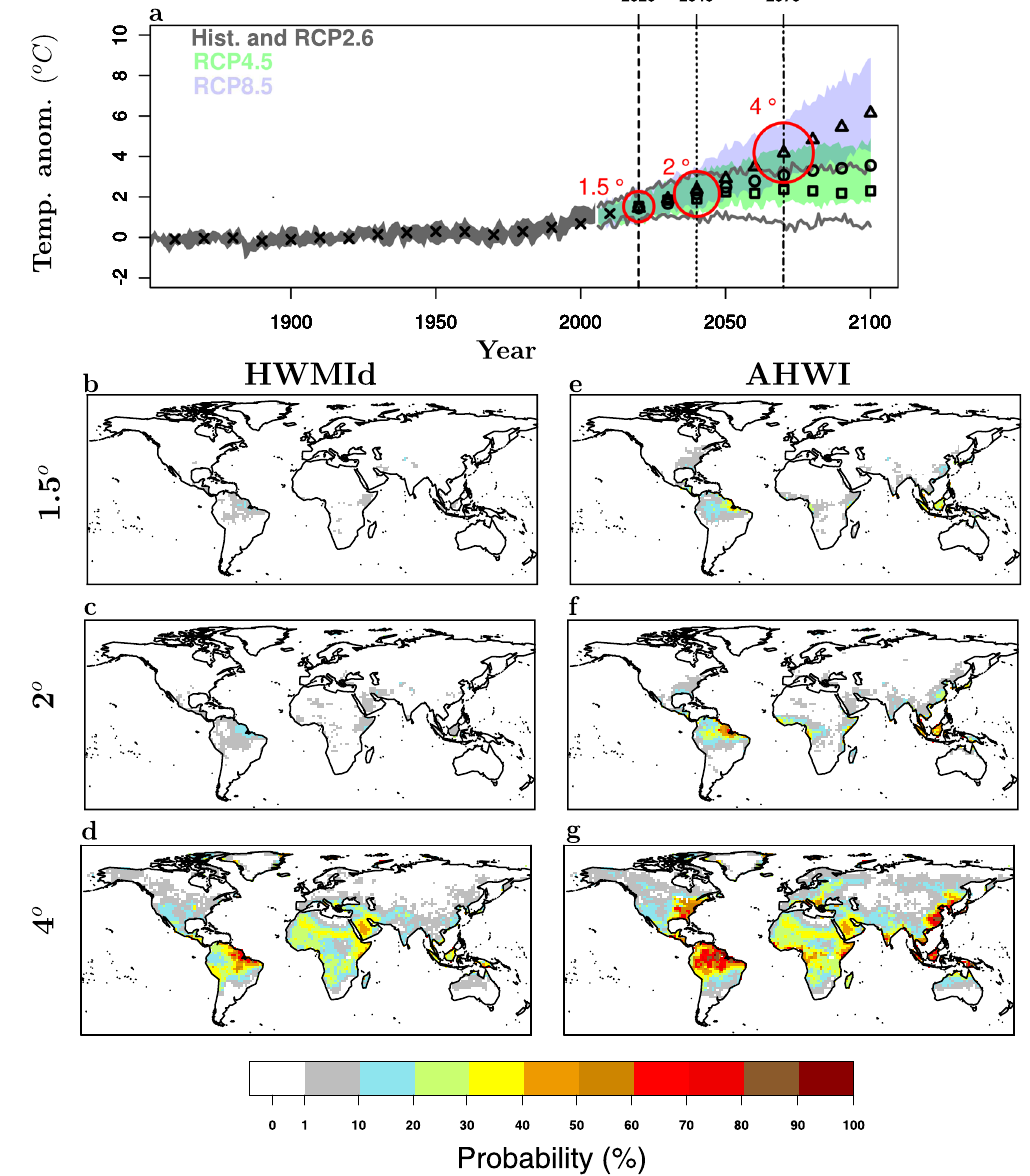
Figure 2. Probability of occurrence of extreme humid heat waves at different warming levels relative to 1861–1880. ( a ), Simulated global mean surface temperature increase as a function of time. Decadal model median over the historical period (1860–2010) are represented by black crosses. Decadal model median over the future period (2011–2100) for the three Representative Concentration Pathway (RCP2.6, RCP4.5 and RCP8.5) scenarios are represented by black squares, circle and triangles, respectively. ( b – d ), Probability of occurrence of heat waves with magnitude greater than the maximum magnitude detected in Russia in 2010 (HWMId > 60) calculated at each grid point for all model years with global mean temperature anomaly relative to 1861–1880 between 1.4° and 1.6° (1.5° warming level, see method), 1.9°–2.1° (2° warming level) and 3.9°–4.1° (4° warming level), respectively. e-g, as b-d but for humid heat waves and the relative Apparent Heat Wave Index (AHWI > 60). This figure has been produced using R version 3.3.2